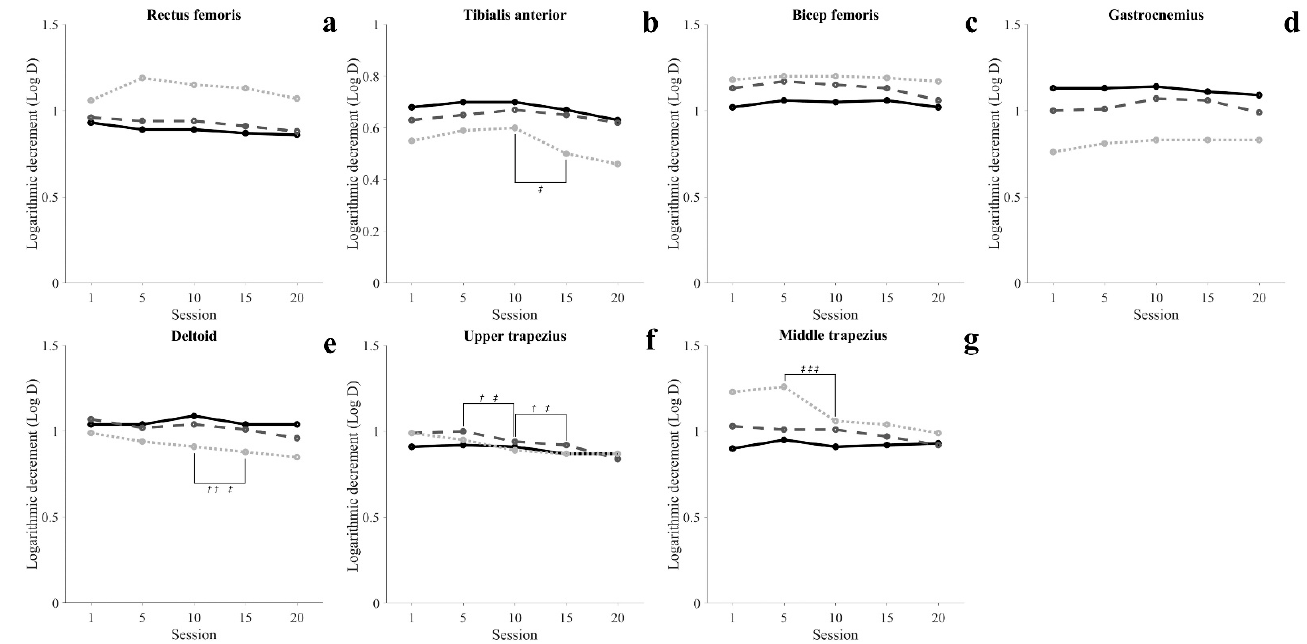
Figure 6. Time-series graphs of significant difference periods for muscle elasticity (sitting position: solid line; standing position: dashed line; wide standing position: dotted line). † Significant differences in a standing position, † = p < 0.05, †† = p < 0.01. ‡ Significant differences in a wide standing position, ‡ = p < 0.05, ‡‡‡ = p < 0.001.